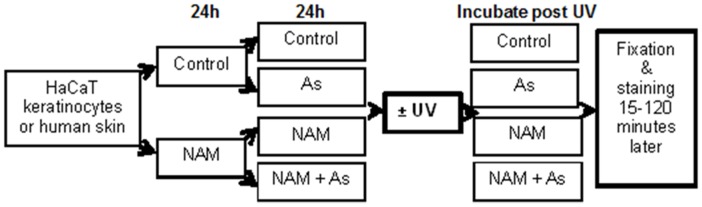
HaCaT human keratinocytes or ex vivo human skin samples were incubated ± 50μM nicotinamide (NAM) for 24h, and then incubated ± NAM and ± 2μM sodium arsenite (As) for a further 24h.Samples were then irradiated with a single, fixed dose of solar-simulated UV (2J/cm2), before once again being incubated ±NAM and ±As as per their pre-irradiation treatment allocation. The HaCaT cells were allowed to incubate for various periods before fixation; 15, 30, 45 and 75 minutes for oxidative DNA damage and 15, 45, 75 and 120 minutes for cyclobutane pyrimidine dimers. Skin samples were incubated for 45 minutes post-irradiation, when peak levels of DNA photolesions were observed.